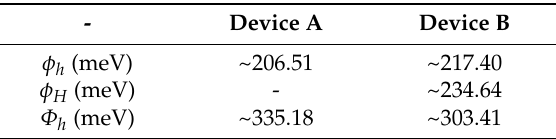
Table 2. Values of different valence band barrier heights for the two p-EBLs. Reproduced from Ref. [24], with the permission of American Chemical Society.